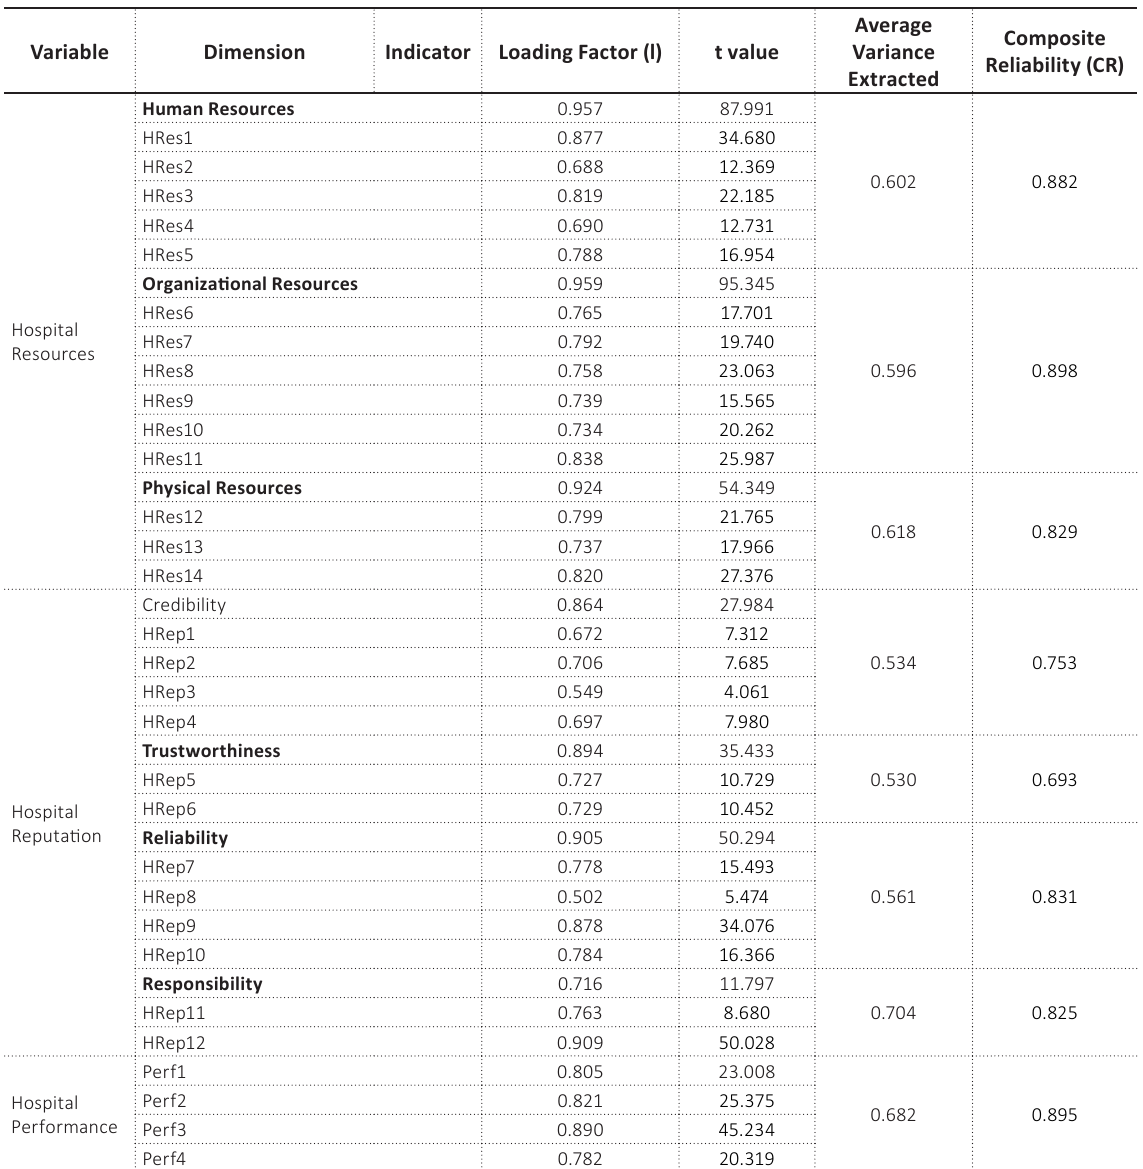
Table 2. Outer model